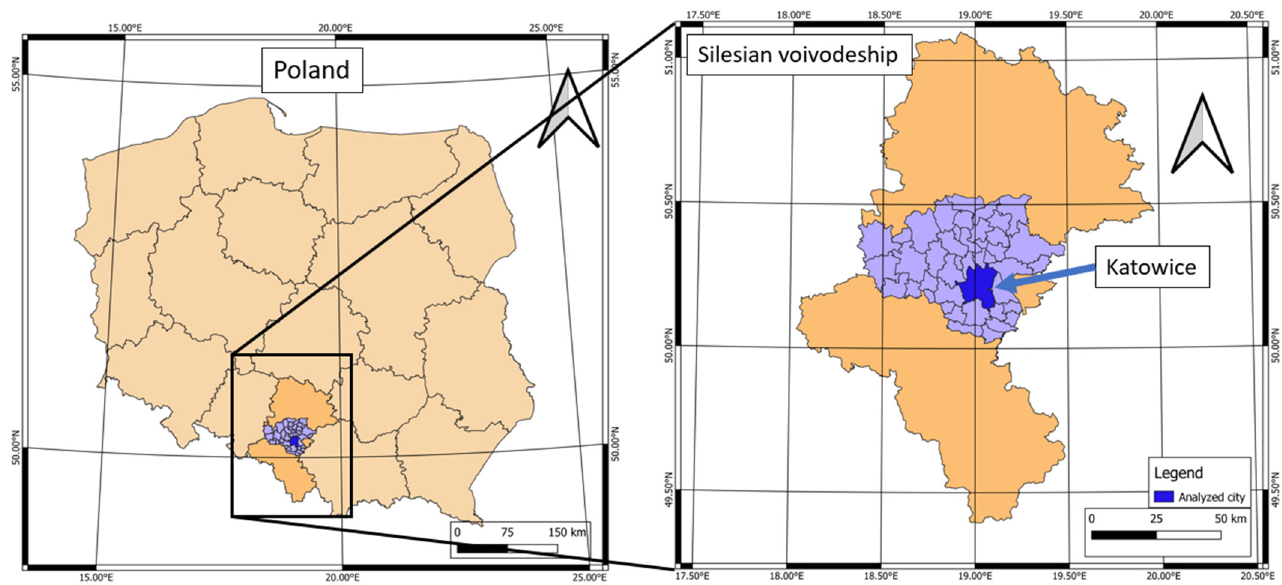
Figure 3. Location of the case study area.